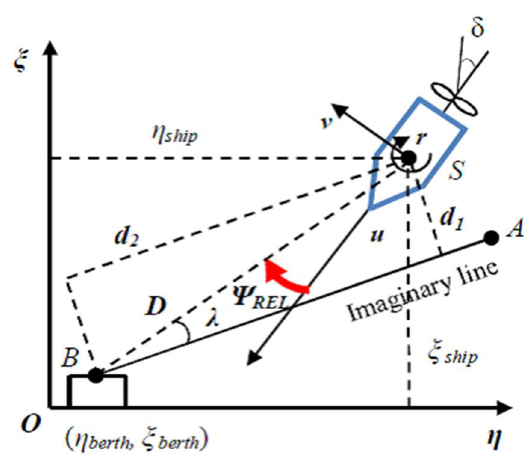
Figure 2. The coordinate parameters of inputs for the artificial neural network (ANN) controller.